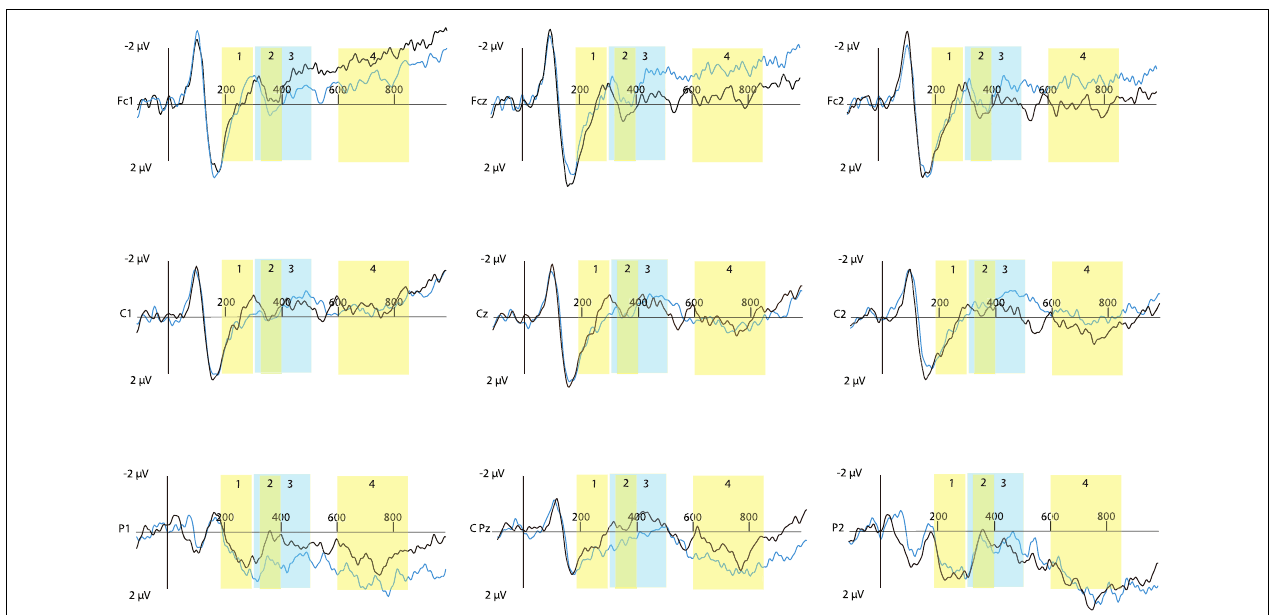
the False-Mismatched condition, the black line shows the False-Matched condition.The limits of each of the four time windows for analysis are